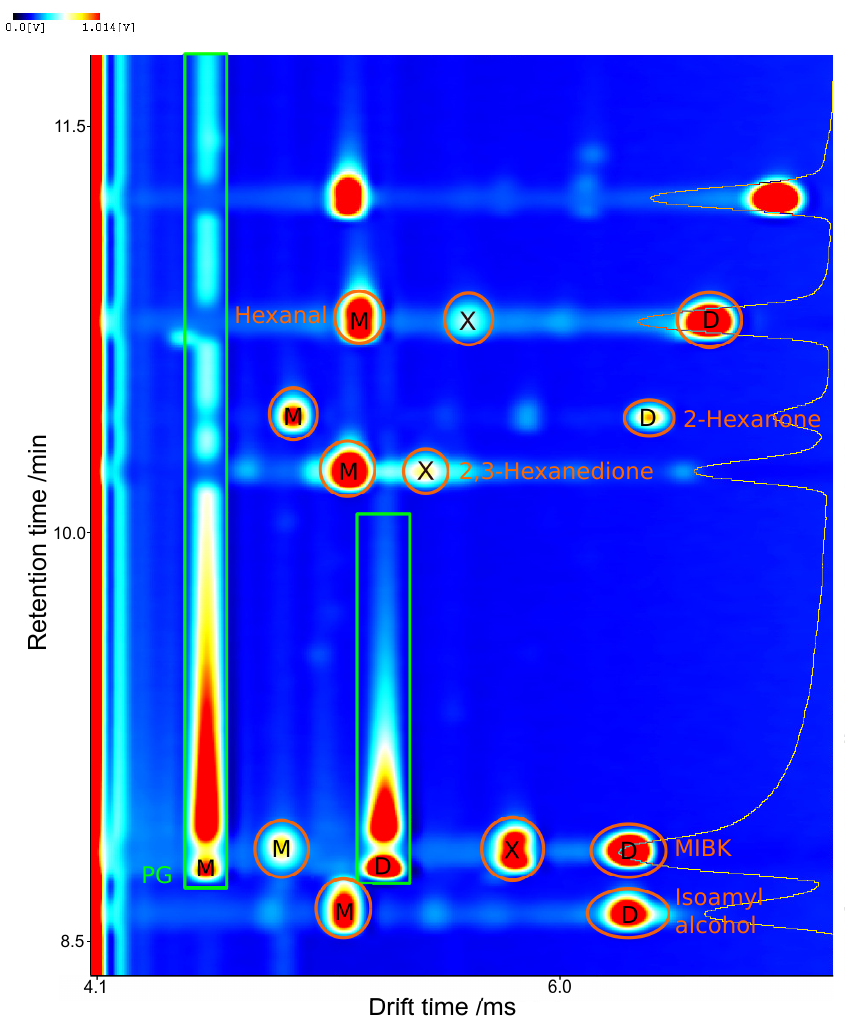
Figure 3. Section of a spiked, otherwise flavorless e-liquid, showing the coelution of propylene glycol, MIBK, 2,3-hexanedione, and the resulting creation of mixed dimers (X) between the drift times of monomers (M) and dimers